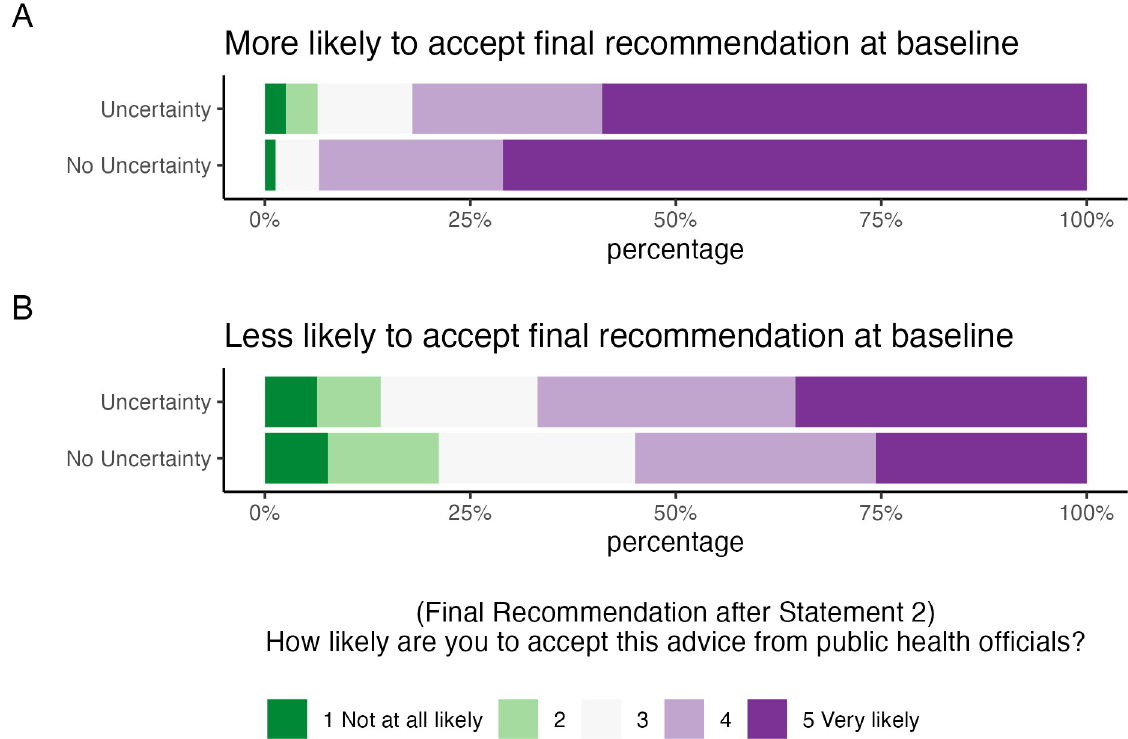
Fig 1. Distribution of agreement with the final recommendation. The top panel (A) shows the agreement between treatment arms among those who were more likely to agree with the final recommendation at baseline; the bottom panel (B) shows agreement between treatment arms among those less likely to agree with the final recommendation at